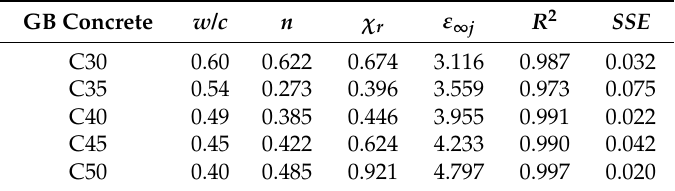
Table 6. Jonscher Model: Fitting Coefficients with f r = 0.1 GHz and Goodness of Fit for Equation (7). GB Concrete w /